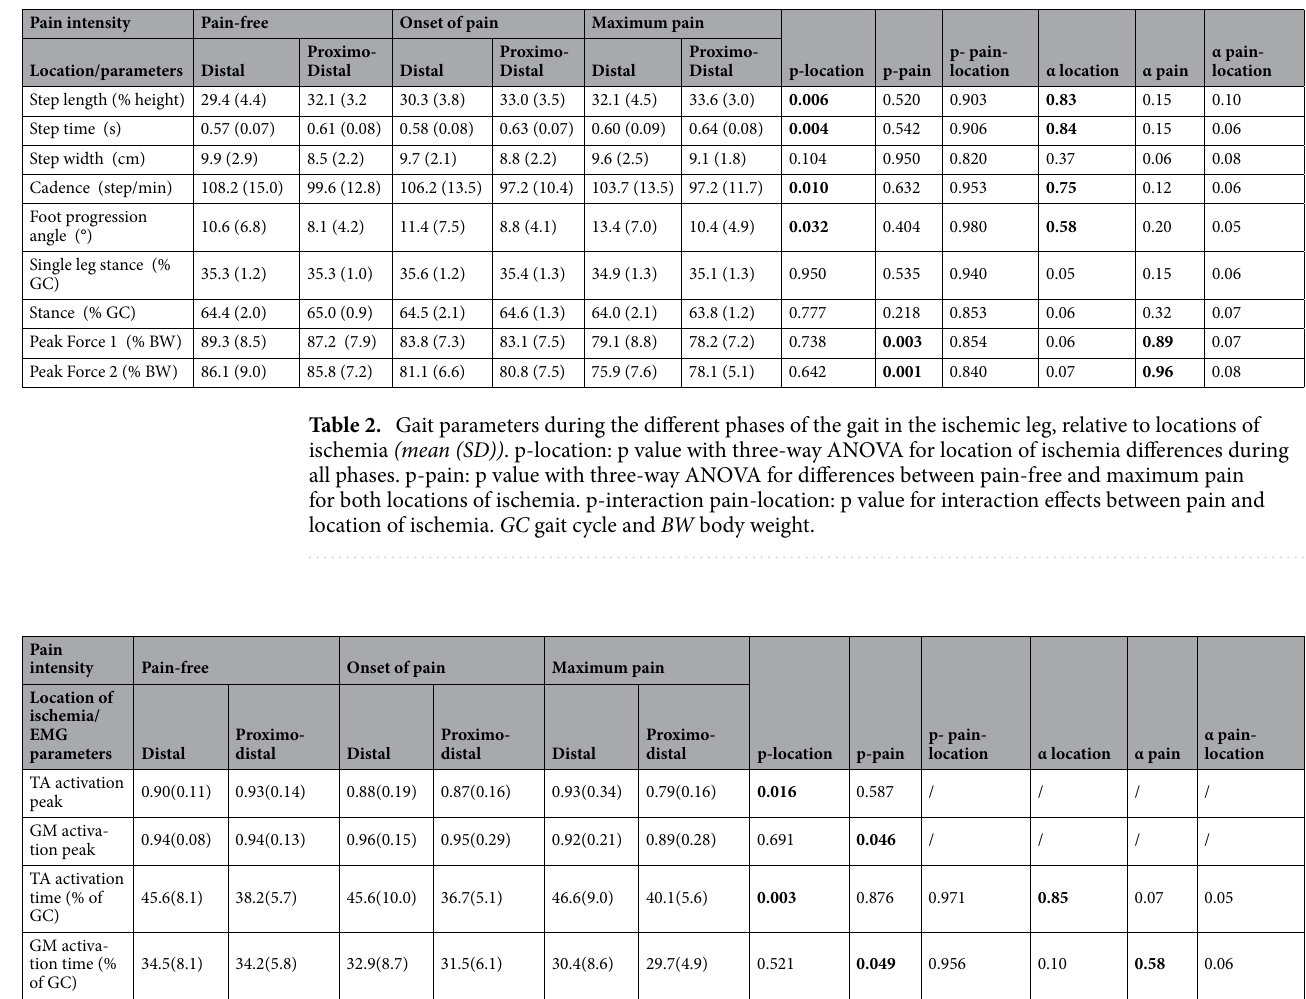
Table 3. EMG parameters during the different phases of the gait in the ischemic leg, relative to locations of ischemia (mean (SD)) . p-location: p value with three-way ANOVA for location differences during all phases. p-pain: p value with three-way ANOVA for differences between pain-free and maximum pain for both locations of ischemia. p-interaction pain-location: p value for interaction effects between pain and location of ischemia. GC Gait Cycle./: Kruskal Wallis test was